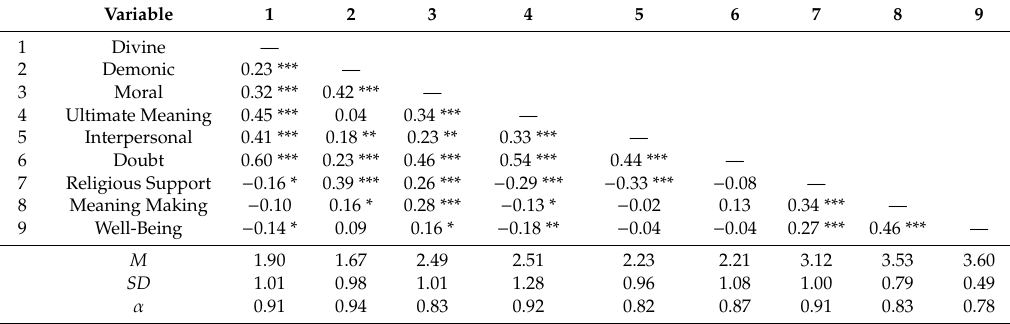
Table 1. Descriptive statistics and bivariate correlations between the variables included in the study.